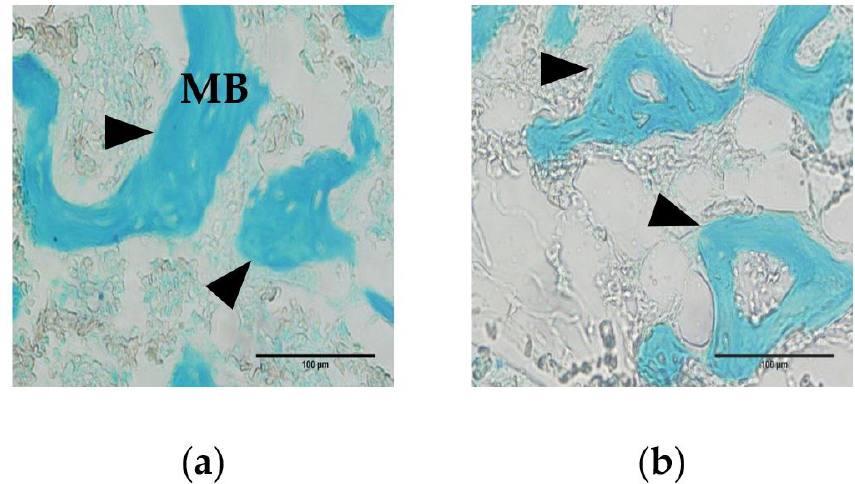
Figure 1. Alcian blue staining of tibial sections from Hy-Line W36 hens. Medullary bone (MB) was observed in the bone marrow cavity. ( a ) In 25-week-old hens, thickened trabeculae were observed (arrowhead); ( b ) In 52-week-old hens, thinner trabeculae were observed. Table 2. Histological parameters of Hy-Line W36 hens tibial cross-sections. Measurement